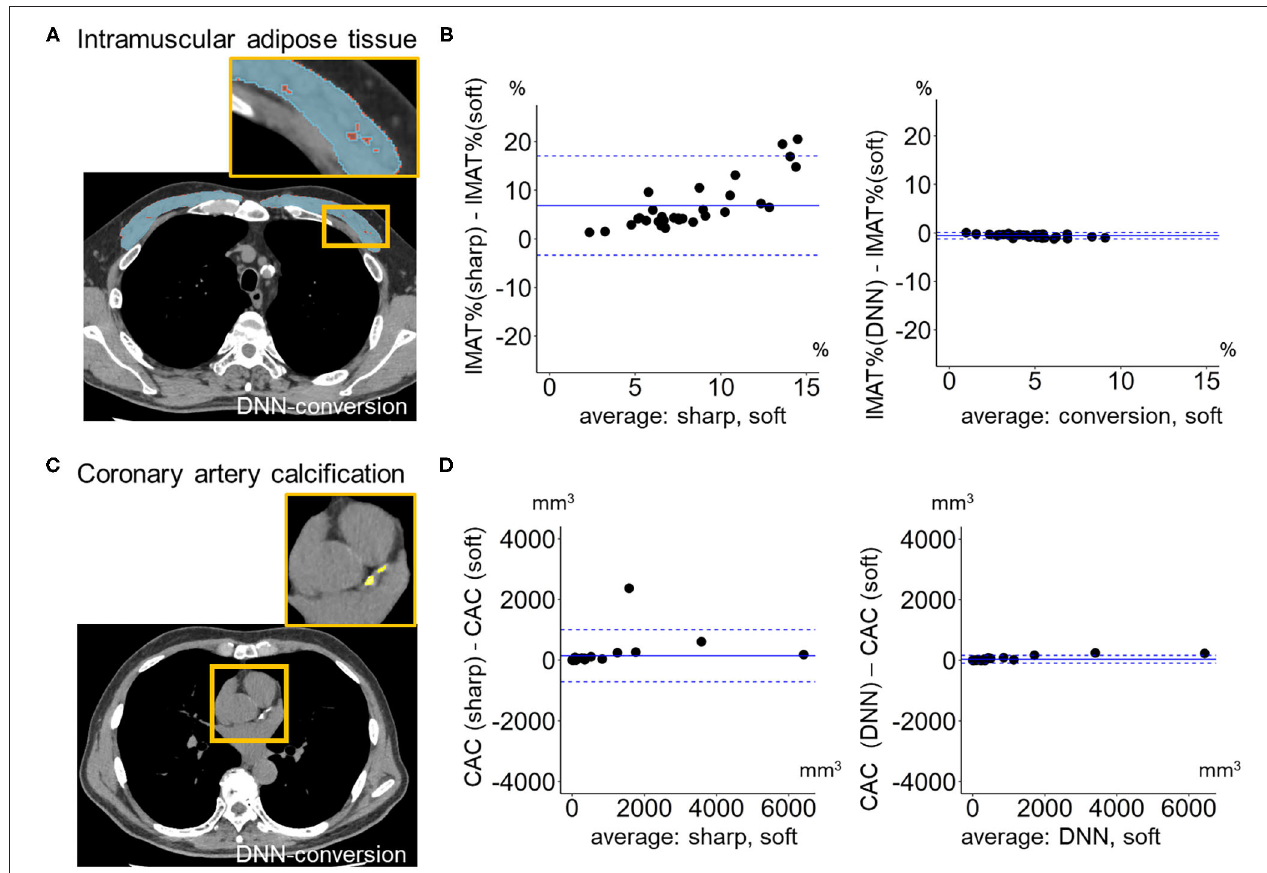
FIGURE 7 | Quantification of intramuscular adipose tissue and coronary artery calcification on deep learning-based kernel-converted images. (A) Intramuscular adipose tissue (IMAT, yellow) in pectoral muscles (blue) on the DNN-converted image near the top of the aortic arch. (B) Bland-Altman plots of the volume percentage of IMAT to pectorals muscles (IMAT%) showed that IMAT% on DNN-converted and soft-kernel images in the validation dataset ( n = 30) were close to each other. (C) Coronary artery calcification (CAC, yellow) on DNN-converted image. (D) Bland-Altman plots of the volume of CAC showed that CAC volume on DNN-converted and soft-kernel images was close to each other. Solid blue line indicates the mean difference (bias) between the two measurements. Upper and lower dashed lines indicate 95% limits of